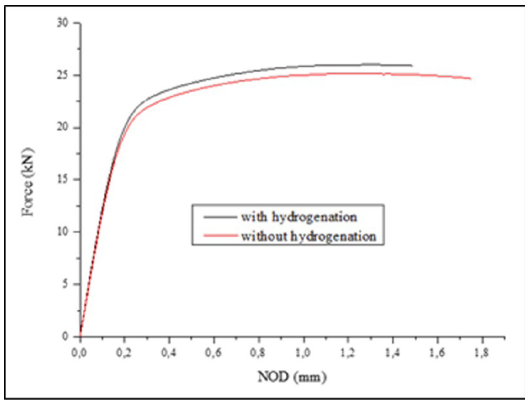
Figure 17. Average force vs. Notch-Opening Displacement curves for base metal, ASTM A182 F22 steel, without and with